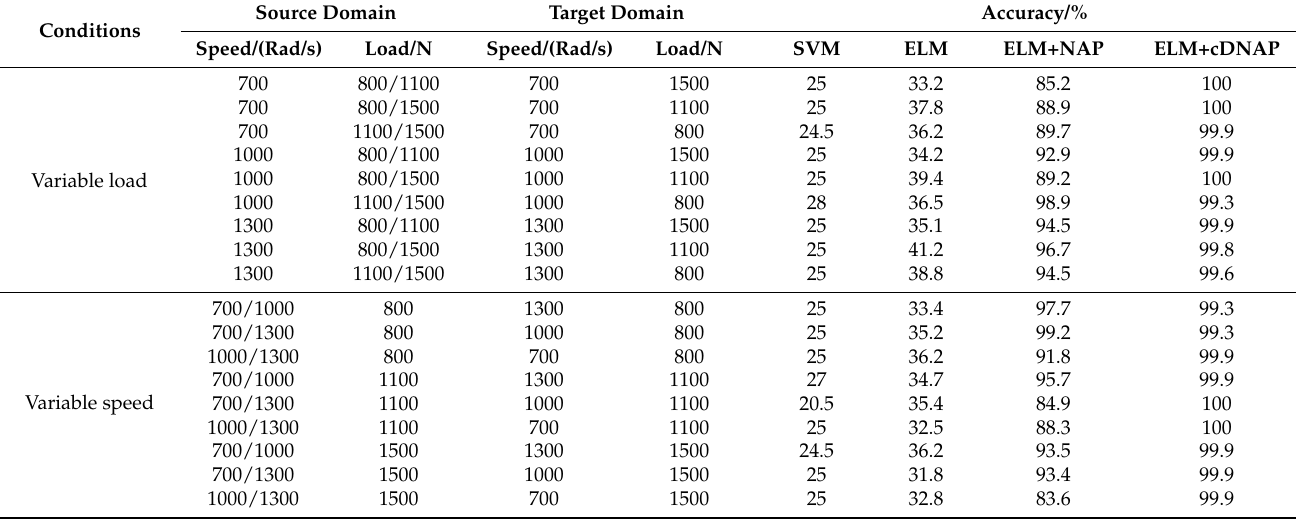
Table 2. Fault diagnosis results of a single working